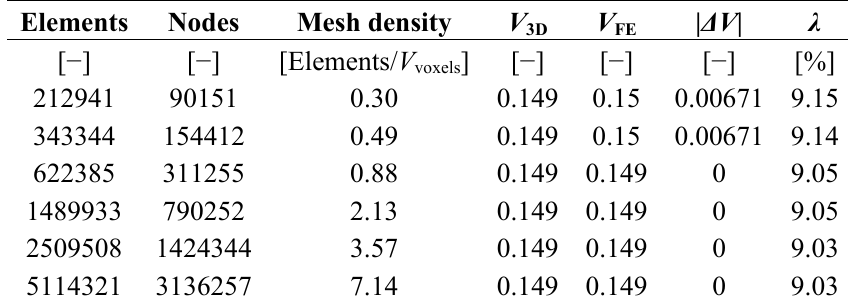
Table 1. Convergence analysis of the sintered hollow sphere structure (HSS)